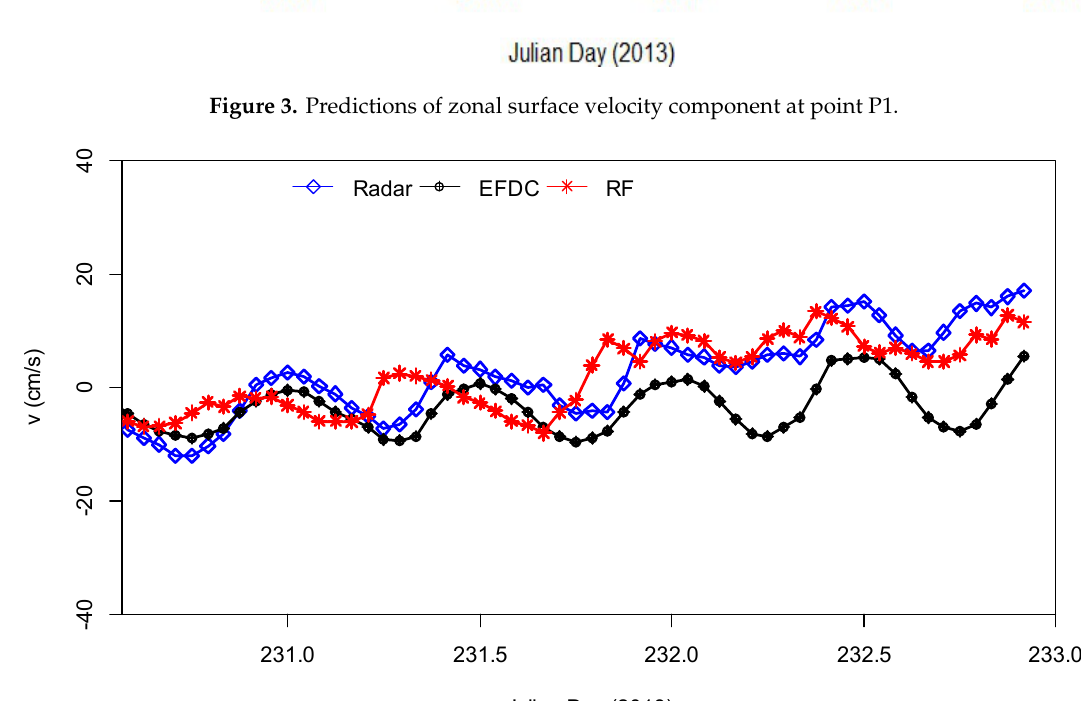
Figure 4. Predictions of meridional surface velocity component at point P1.